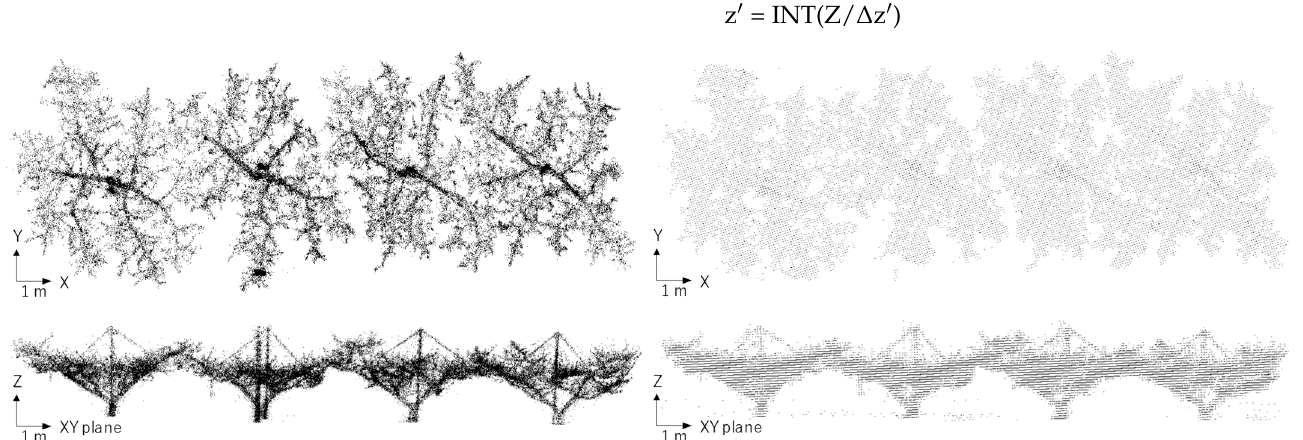
Figure 5. The voxel model was built from the point cloud model: left top —top view of the point cloud model; left bottom —side view of the point cloud model; right top —top view of the voxel model; right bottom —side view of the voxel model.